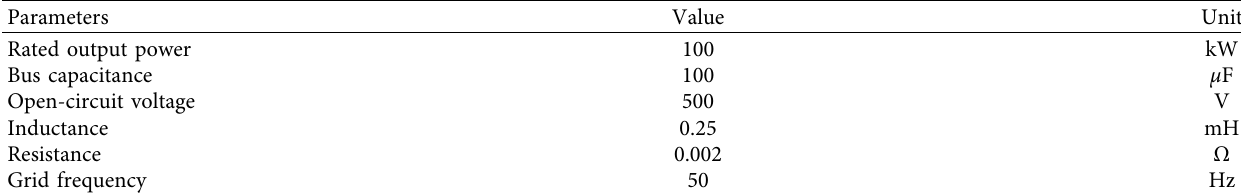
Table 1: Primary parameters of the main circuit.